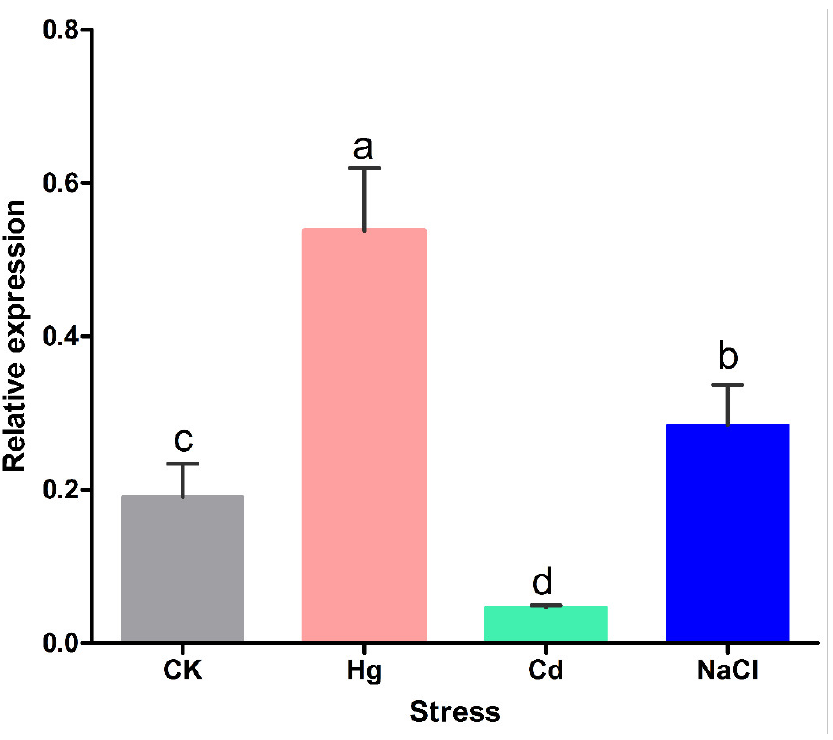
Figure 3. The expression level of the BrCYP71A15 gene under NaCl, Cd and Hg stresses. Colors indicate different stresses, and letters above the error bar represent significant differences at p > 0.005.